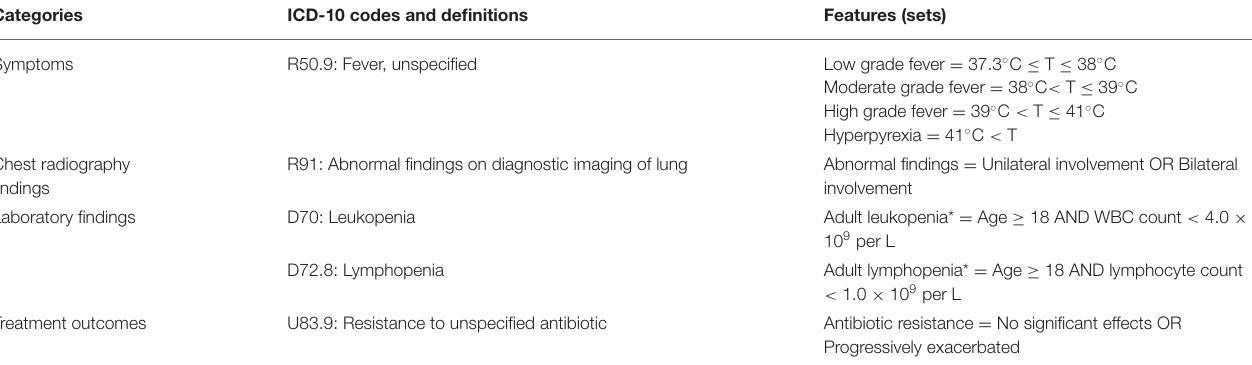
TABLE 1 | Feature definitions of pneumonia with uncertain etiologies cases according to the concept categories and the International Classification of Diseases codes-10.